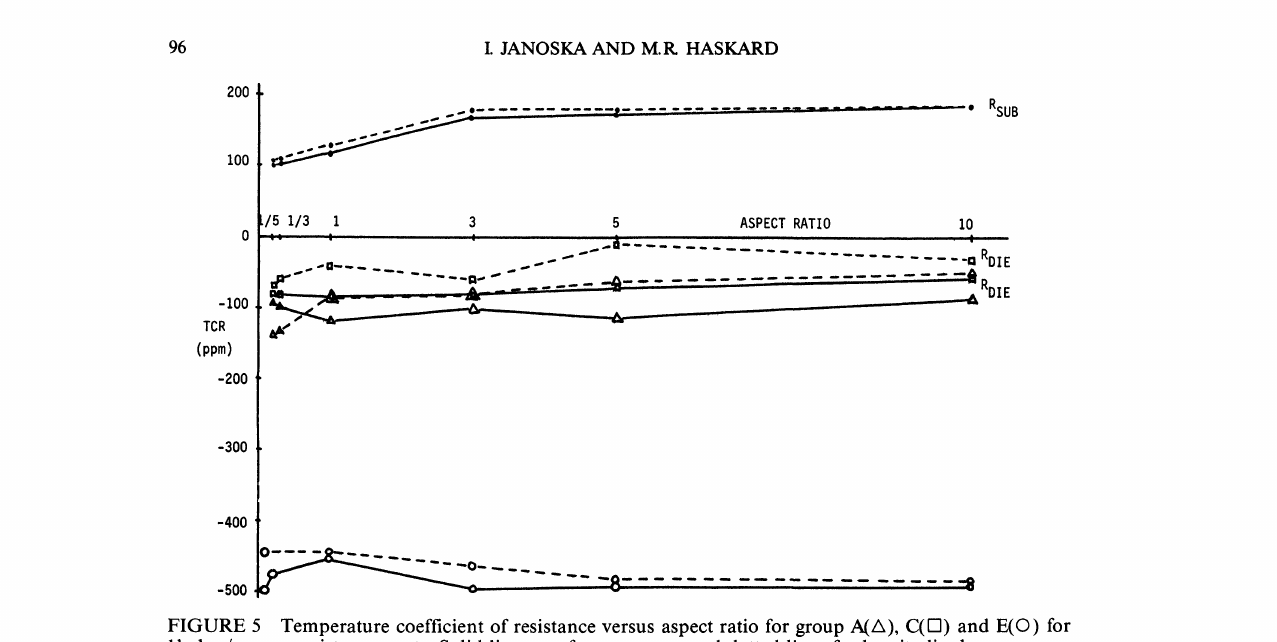
FIGURE 5 Temperature coefficient of resistance versus aspect ratio for group A(A), C(U]) and E(O) for lkohm/square resistance paste. Solid lines are for transverse and dotted lines for longitudinal sensors.